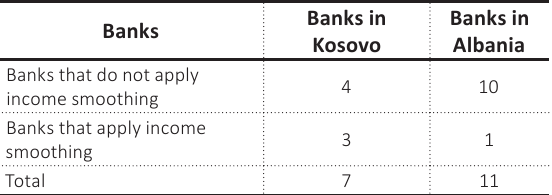
Table 1. Information about variables